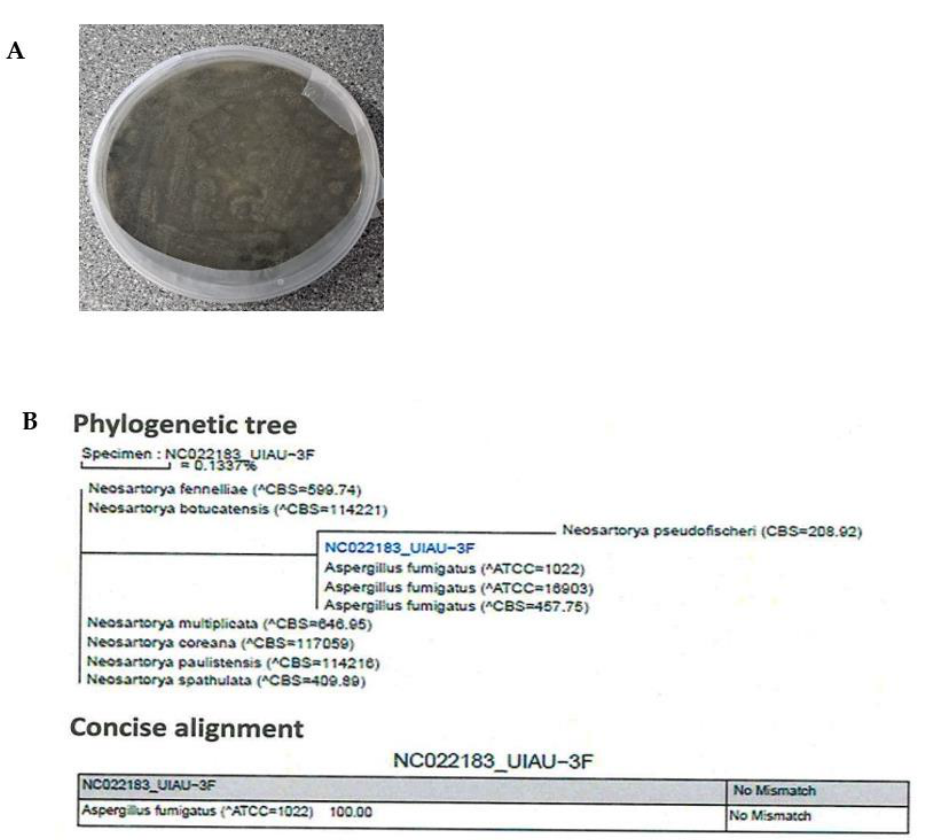
Figure 1. ( A ) Colony characteristics of Aspergillus fumigatus UIAU-3F grown on ISP2 agar at 28 °C for 7 days. ( B ) Phylogenetic tree of Aspergillus fumigatus UIAU-3F.